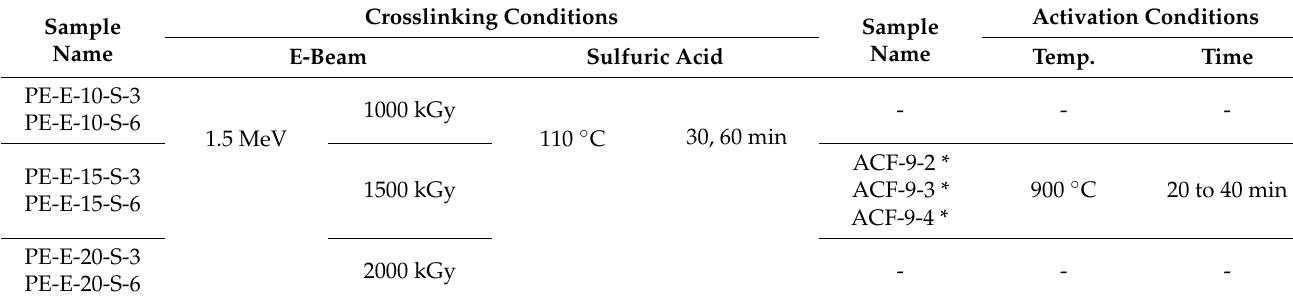
Table 1. Sample names according to crosslinking and activation